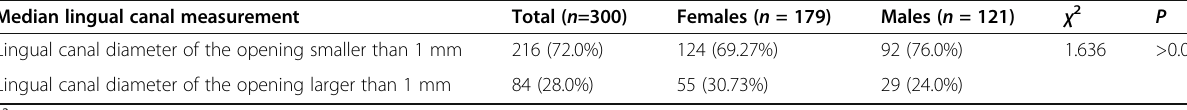
Table 4 MLC larger and smaller than 1 mm